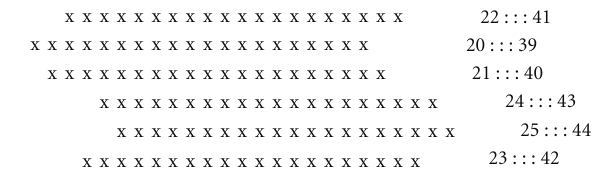
Figure 1: Example of a reformatted pre-miRNA structure and predicted localization of a miRNA/miRNA ∗ complex in the pre-miRNA structure. (a) Secondary structure of the pre-miRNA of ath-mir156a in standard representation. The mature miRNA is shown in larger italic characters. (b) Section of the pre-miRNA in an alignment-like format. First and fourth line show the sequence except the sequence region of the hairpin loop; lines 2 and 3 describe the state of the opposing nucleotides: a base pair is marked by “+”, nucleotides of an internal loop by “ − ” in both lines, and nucleotides that are part of an asymmetrical internal or a bulge loop by “ | ”. In the fifth line a base pair is marked by “M”, a non-pair by “N”, a deletion in the top strand by “D”, and an insertion in the top strand by “I”. (c) Positions predicted as miRNA/miRNA ∗ complexes are marked by “x” and their relative positions in the